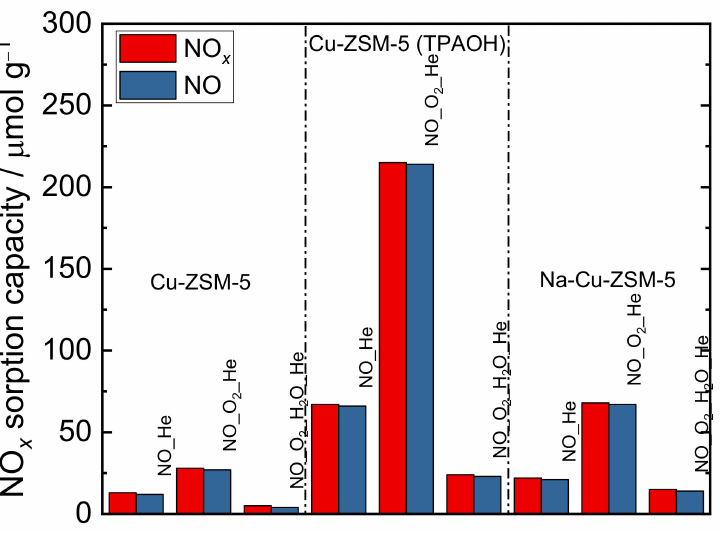
Figure 7. NO x adsorption capacity of the selected Cu-exchanged